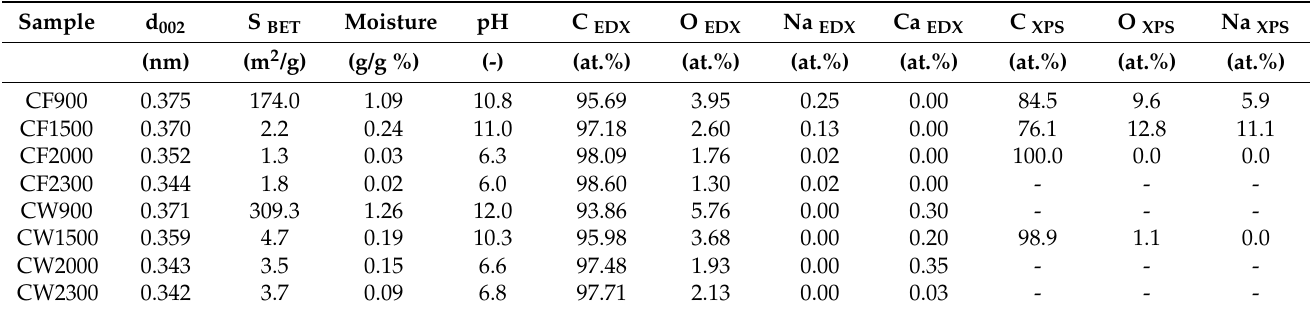
Table 2. Properties of prepared carbon fillers. Interlayer distance by XRD (d 002 ), specific surface area (S BET ), moisture uptake, pH in aqueous suspension, bulk chemical composition by EDX and surface composition by